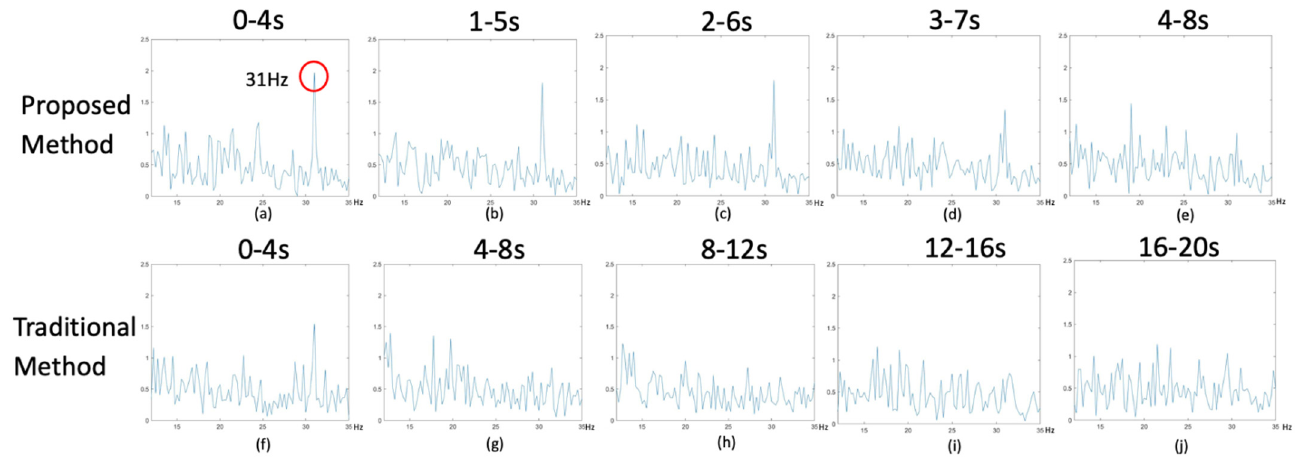
Figure 5. Comparison of the proposed method with the traditional method in 31 Hz brainwave signals. Table 1. The proposed method has five signals in the 15 Hz brainwave signal.